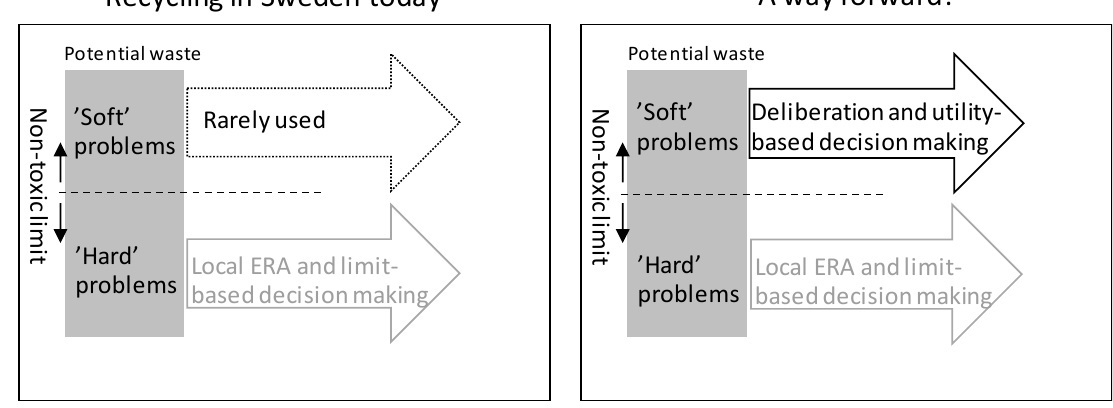
Figure 4. Recycling of what can be characterized as ‘hard’ problems can be solved using local environmental risk assessment and limit-based decision making. Recycling of what can be characterized as ‘soft’ problems are better solved via deliberation and utility-based decision making.